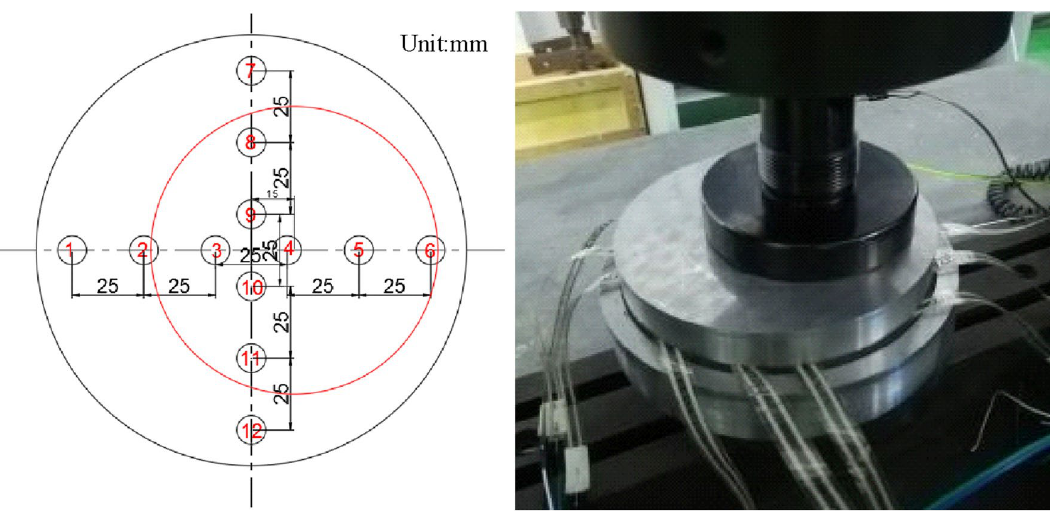
Figure 17. Sensor layout scheme and physical drawing of bias